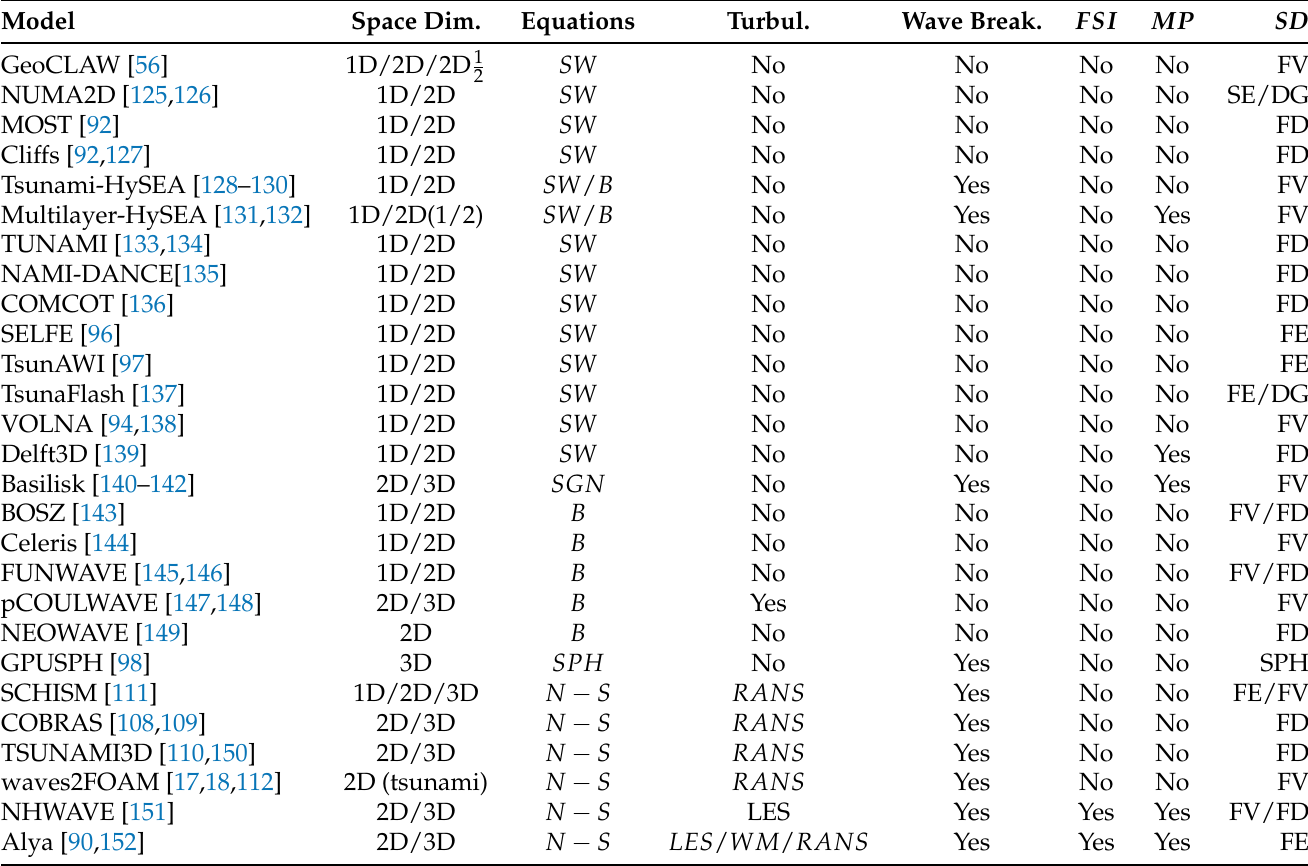
Table A1. Some available tsunami models. Acronyms used in this table: SW Shallow Water, B Boussinesq, SGN Serre– Green–Naghdi, N − S Navier–Stokes, SPH Smoothed Particle Hydrodynamics, LES Large Eddy Simulation, WM Wall Modeled LES, RANS Reynolds Averaged Navier–Stokes equations, FSI Fluid–Structure Interaction, MP Multi-Phase capabilities for erosion and sediment transport, and SD for spatial discretization. The use of 2 D ( 1/2 ) indicates that the model can run in multi-layer modality [95]. Storm surge and ocean dynamics models are omitted.